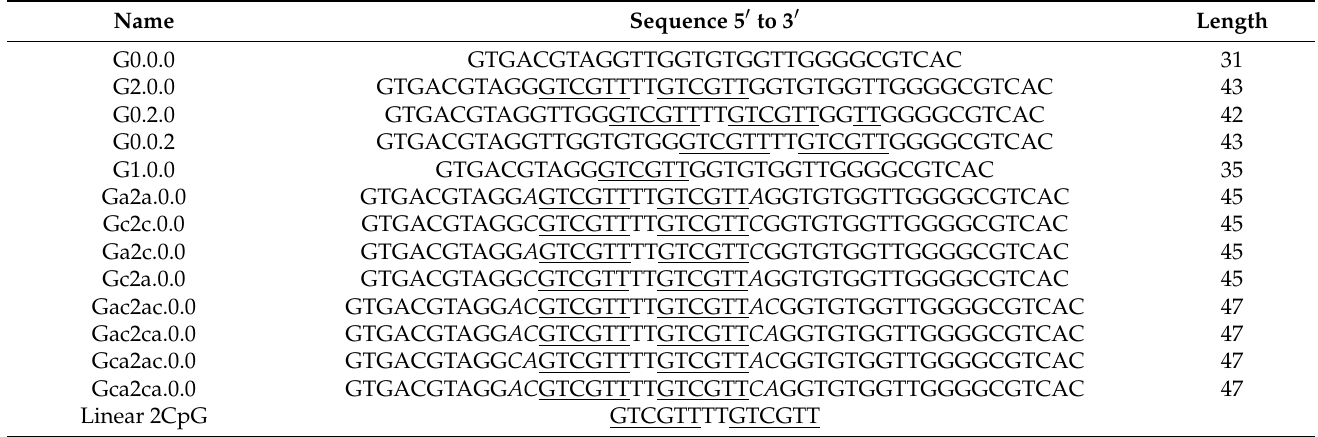
Table 1. Sequences of loop modification oligonucleotides in this